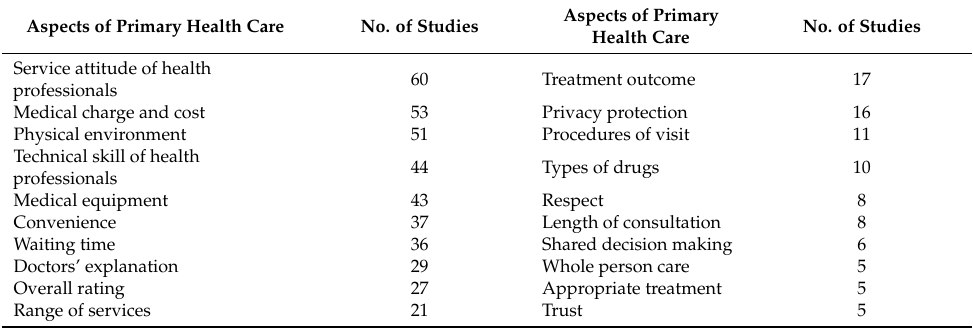
Table 2. The top 20 most frequent evaluated primary health care aspects in the 65 studies with self-developed